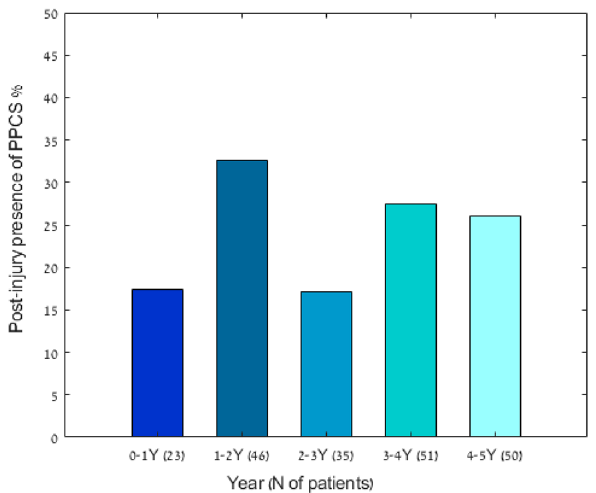
Figure 2. Presence of persistent post-concussion syndrome, 1–5 years after mild traumatic brain injury. Presence of persistent post-concussion was diagnosed based on the Rivermead Post-Concussion Questionnaire ( p = 0.489).